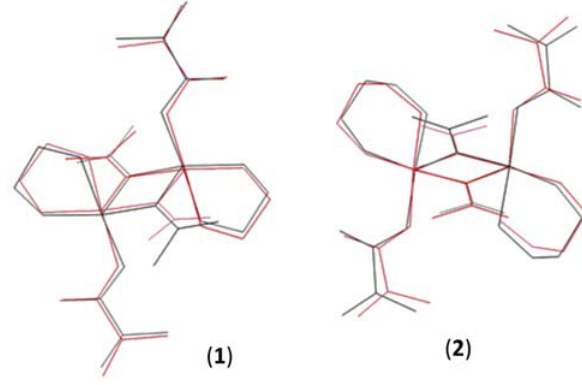
Fig. 5. Atom-by-atom superimposition of the calculated structures (black) over the X-ray structure (red); hydrogen atoms have been removed for clarity.